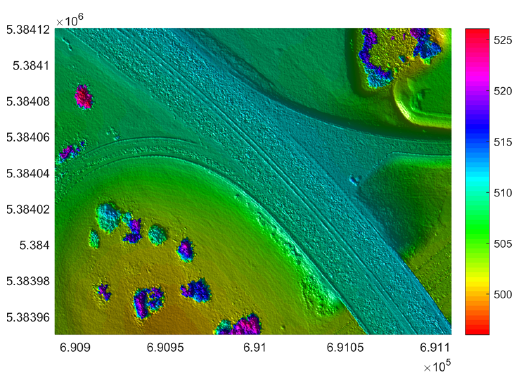
Figure 12. The reconstructed line segments and the unrefined DSM profile in UTM 32N coordinate Figure 10. Part of the DSM in road area. It is noisy in the center of motorway.